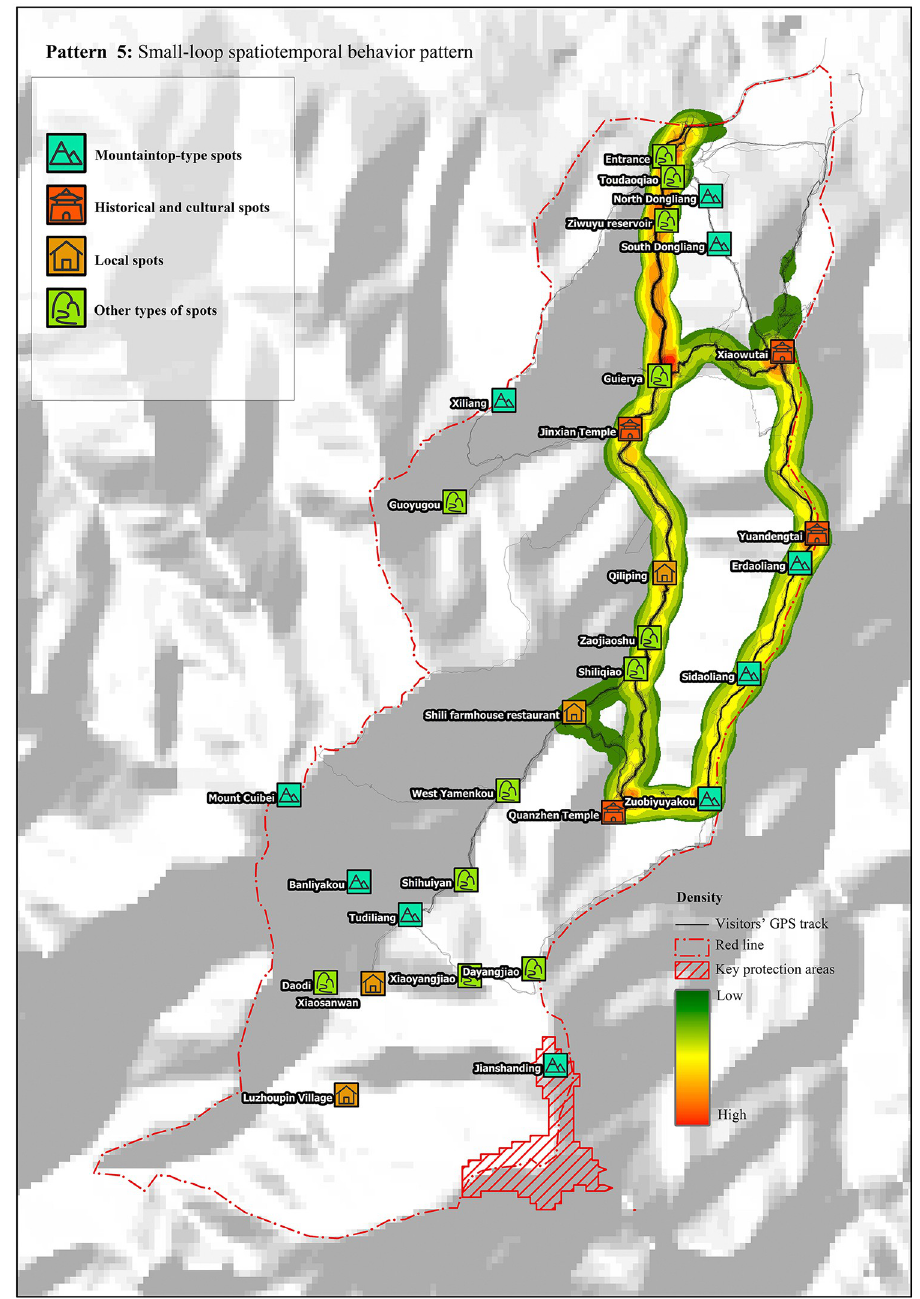
Fig 6. Small-loop spatiotemporal behavior pattern. Reprinted from [https://www.usgs.gov/centers/eros/data] under a CC BY license, with permission from [United States Geological Survey], original copyright [2000]. Short-distance spatiotemporal behavior pattern: Tourists who exhibit this pattern have a strong leisurely nature. Tourists preferred "Natural landscape-historic Culture" for recreation, indicating that tourists in this pattern considered Ziwuyu a daily sightseeing and leisure desti- nation. The probability of tourists in this pattern visiting Guaierya and Xiliang was 56.9% and 58.5%, respectively, and the probability of leaving the study area was 75.4%, as indicated by